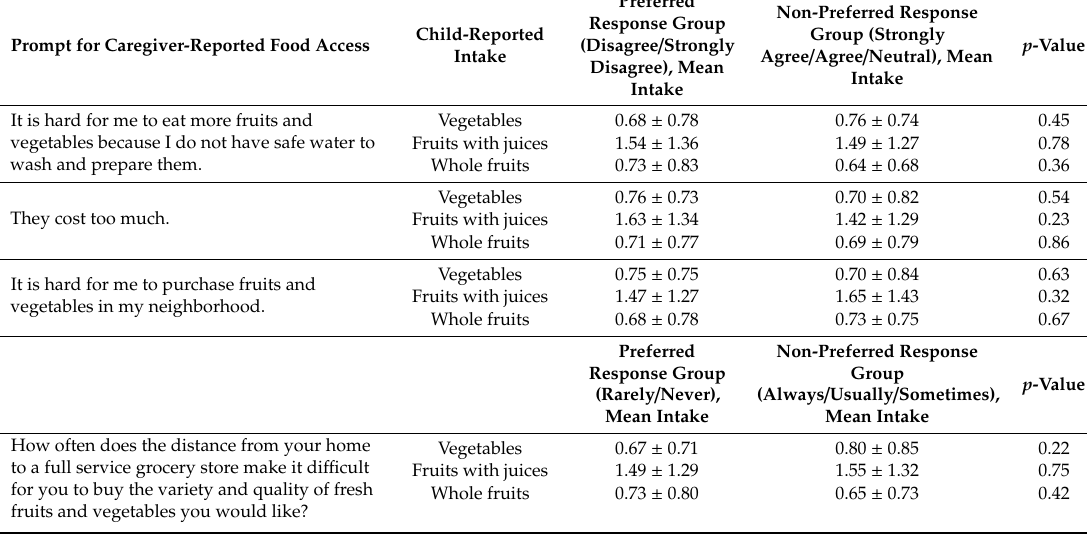
Table 3. Associations between child-reported fruit and vegetable intake and caregiver-reported food